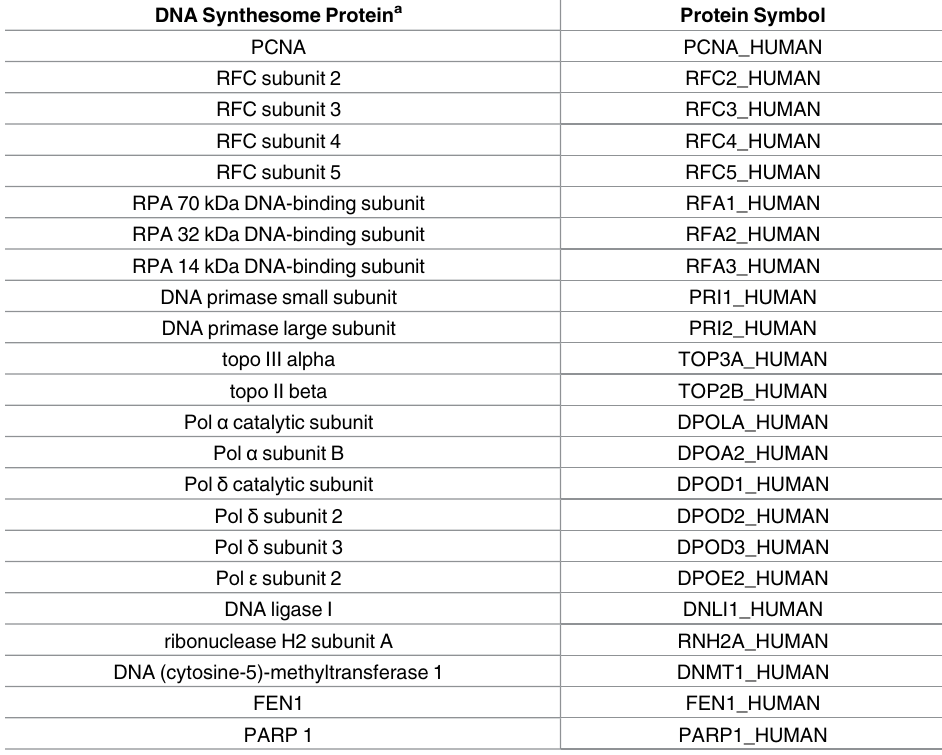
Table 1. Previously identified DNA synthesome proteins or protein subunits identified by massspec- trometry from BN gel with a relative electrophoretic mobility of 0.8–1 MDa. DNA Synthesome Protein a Protein